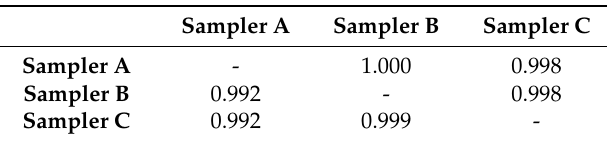
Table A3. Correlation matrix for change in reflectance (change in mean pixel intensity ( ∆ PI; unitless)) by kerosene smoke chamber exposure time-point ( n = 18) among triplicate low-cost passive samplers ( n = 3; Sampler A, Sampler B, Sampler C). Lower panel lists the Pearson’s correlation coe ffi cients ( r ), and the upper panel lists the Spearman’s rank coe ffi cient ( s ).